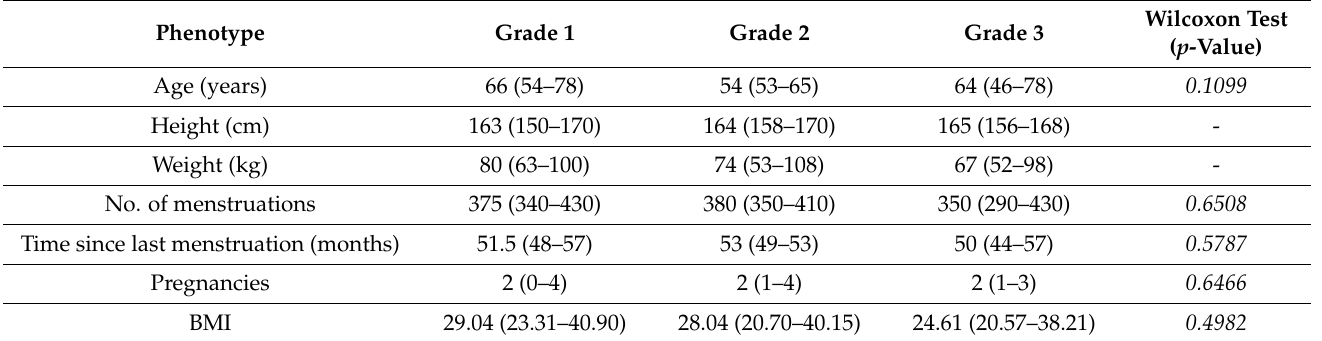
Table 1. Phenotypic data for each grade. Median with range (in brackets) was calculated for each complex trait.